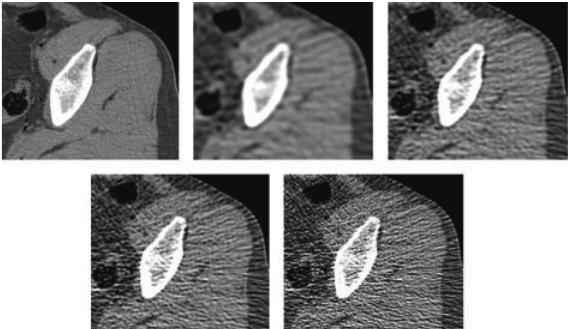
Figure 2: Left to right, upper to lower: reference image, FBP reconstructions obtained with low-pass filter with 𝜙 0 = 0.4 (very low), 𝜙 0 = 0.8 (optimal for MSE), 𝜙 0 = 1.55 (optimal for gradient- ̃𝑓) ), and 𝜙 0 = 4 (very based measure Q (𝑓 0 ,